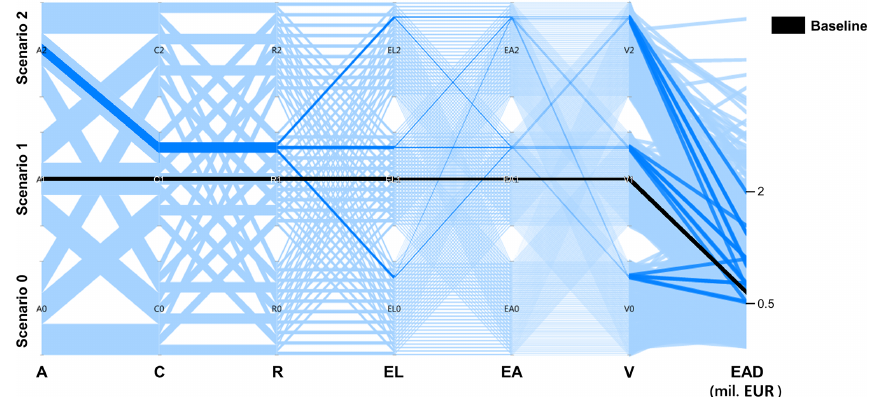
Figure 11. Parallel-coordinate plot representing EAD for change in land use (EL) and vulnerability (V) under fixed baseline catchment and river system scenarios and increasing atmosphere and asset